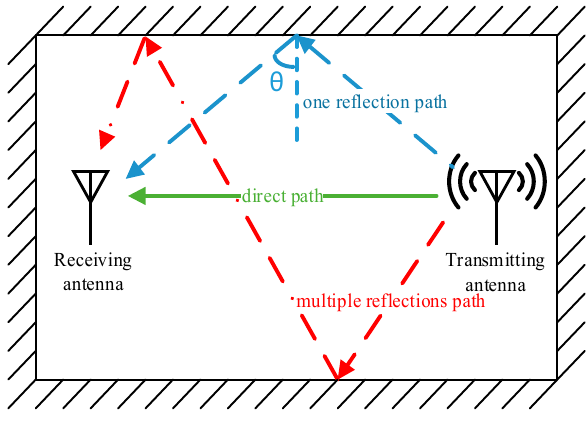
Figure 2. Indoor multipath propagation scenario.